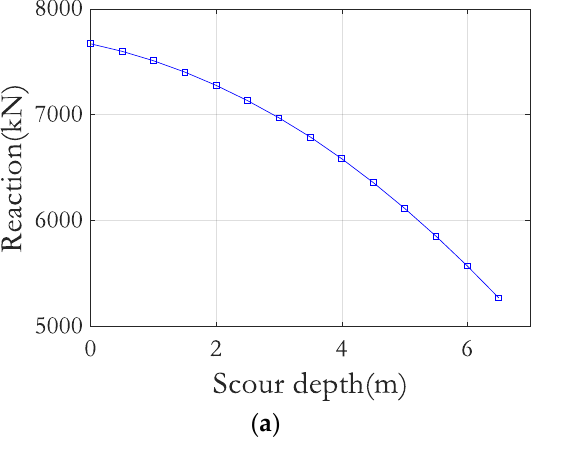
Figure 13. Variation of pull-out reaction: ( a ) allowable reaction; ( b ) reaction at SD = 6.5 cm.